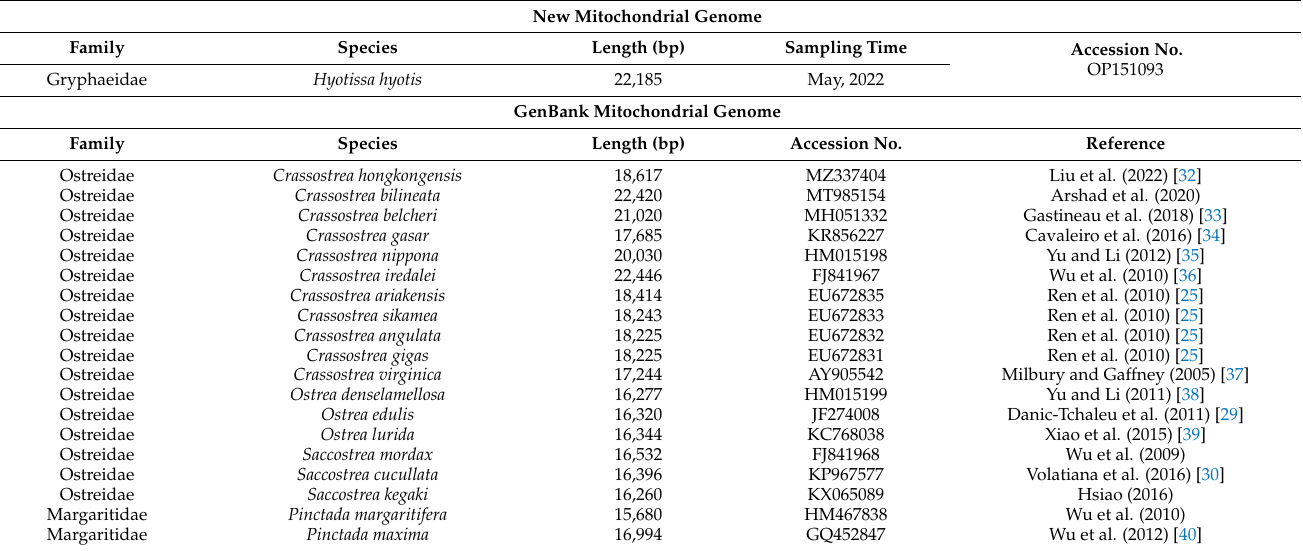
Table 1. List of mtDNA used in the present study. New Mitochondrial